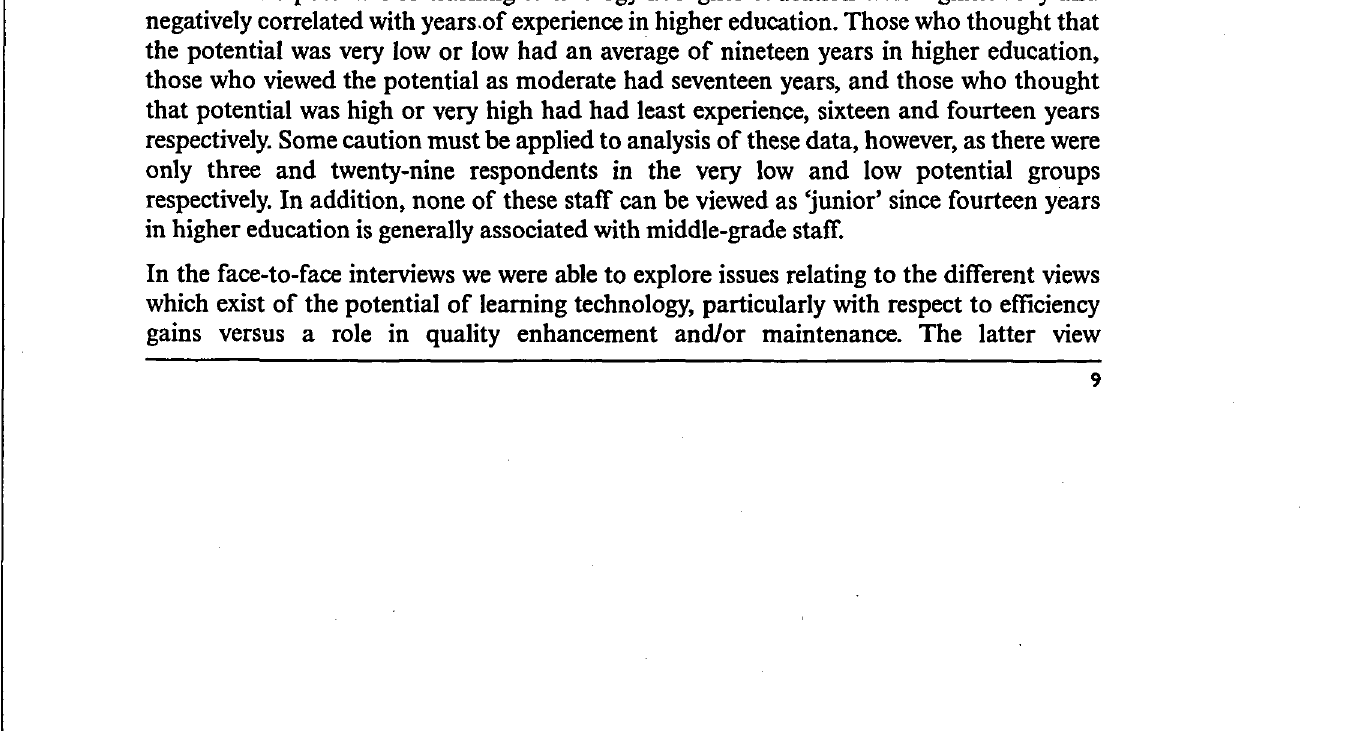
Figure I: Distribution by self-rated experience with learning technology of academic staff who responded to the questionnaire. In total 969 staff